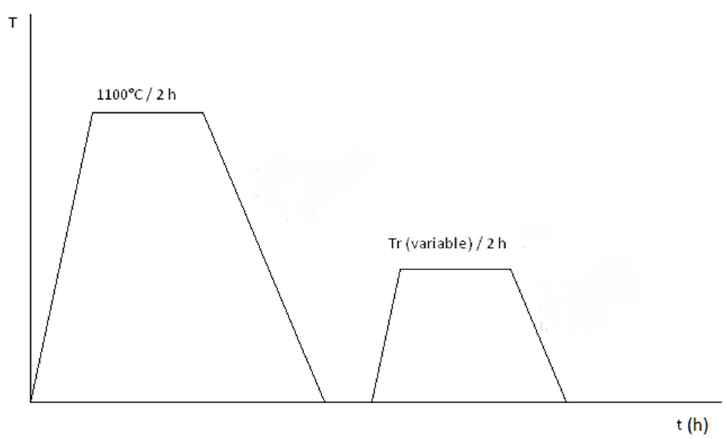
Figure 1. Diagram of the thermal treatment carried out.